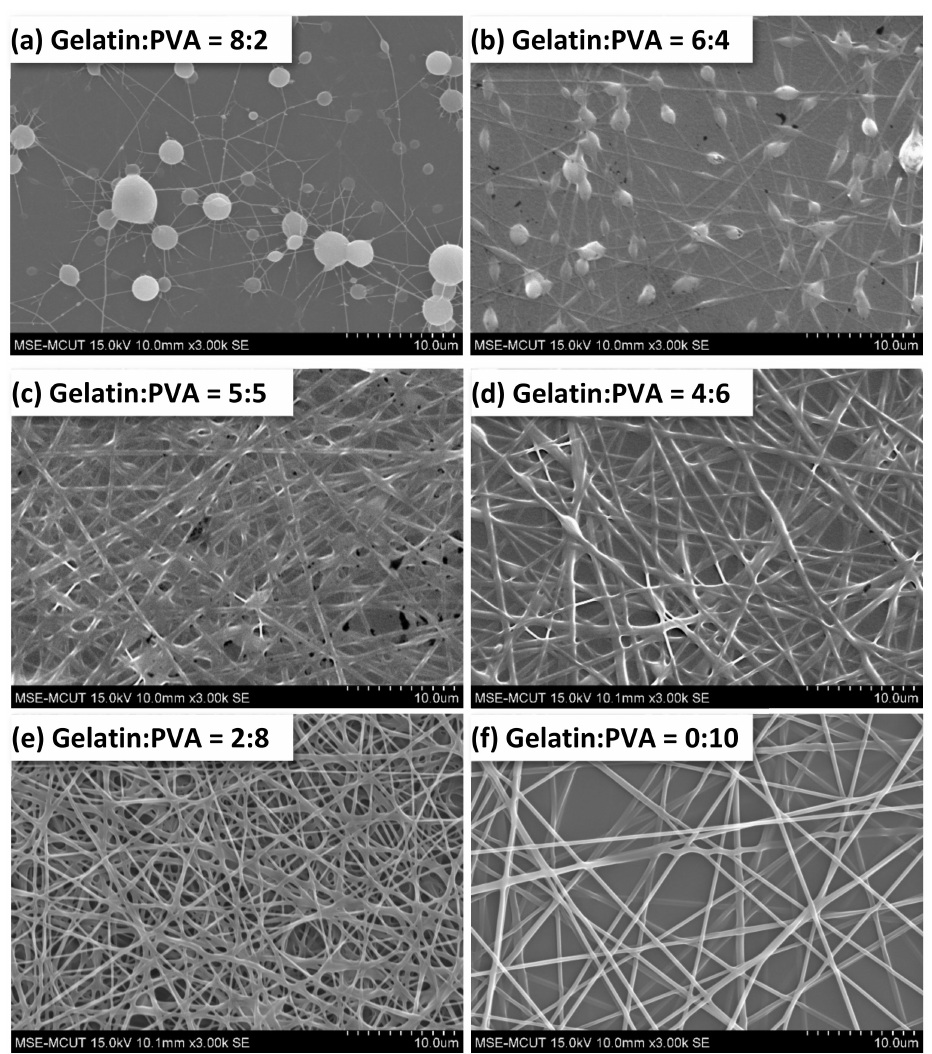
Figure 6. Morphology of electrospun gelatin/PVA mixed nanofibers on top of a film. To quantify the nanofibers’ dimension, we randomly selected fibers from each SEM image and measured their diameters. The average diameters of fibers in different samples are shown in Figure 7. The range of average diameters of fibers falls between 287 and 541 nm, but the diameters of pure 50:50 gelatin/PVA fibers are larger than other samples. The formation of larger diameters can be attributed to the thinning of jets and mutually miscible gelatin and PVA solutions, as observed in the SEM